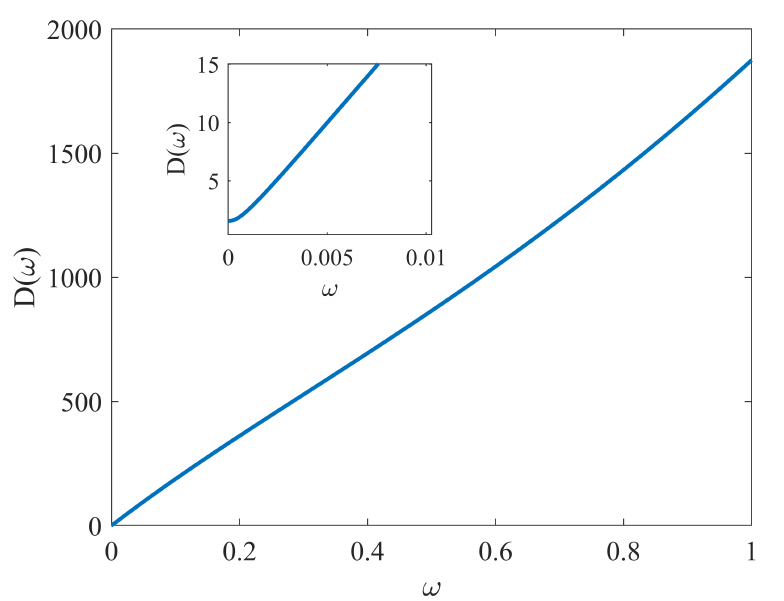
Figure 4. The values of function ψ ( s ) in (23).